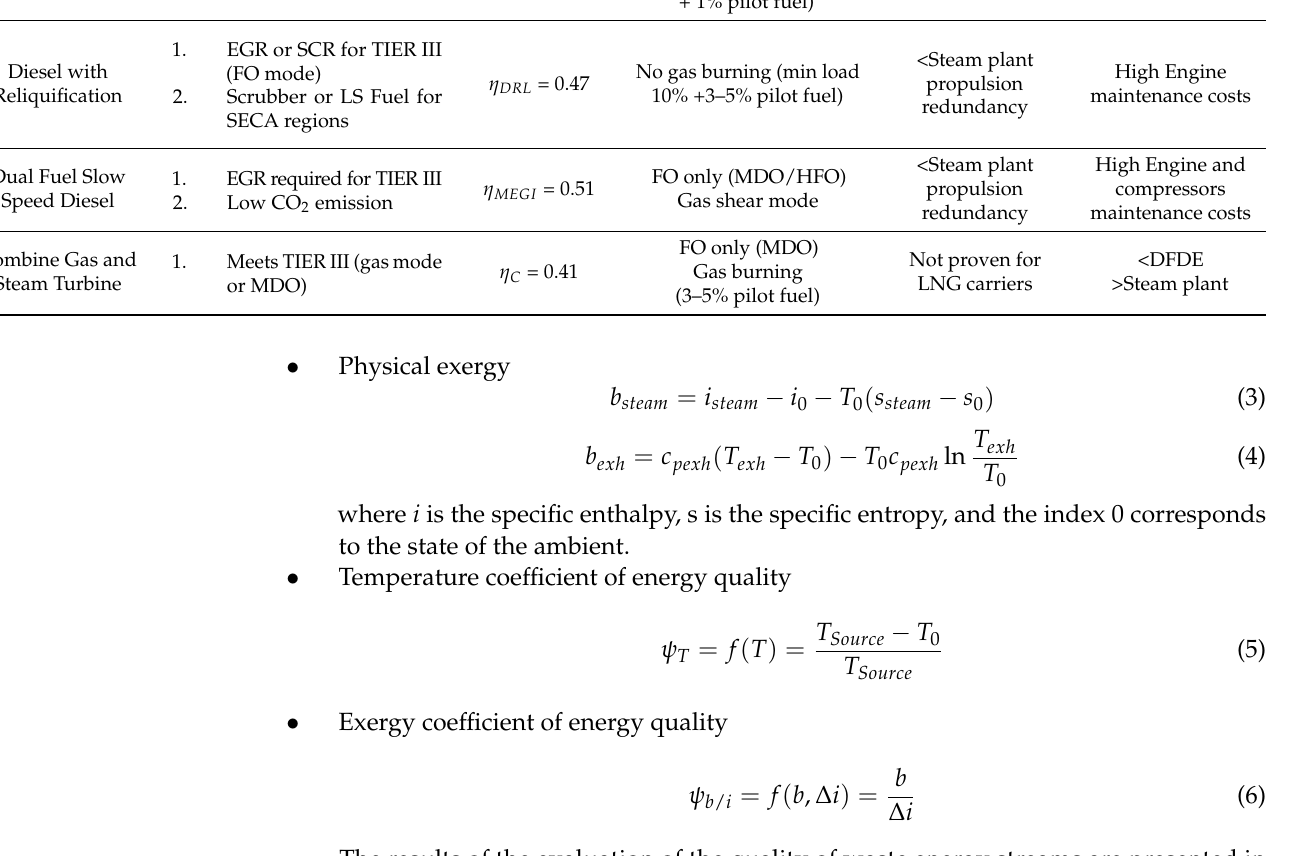
Table 2. Results of the quality assessment of the main waste heat energy sources. Reproduced with permission from the MAPE Conference Organizing Team, published by New Trends in Production Engineering 2018. Flow